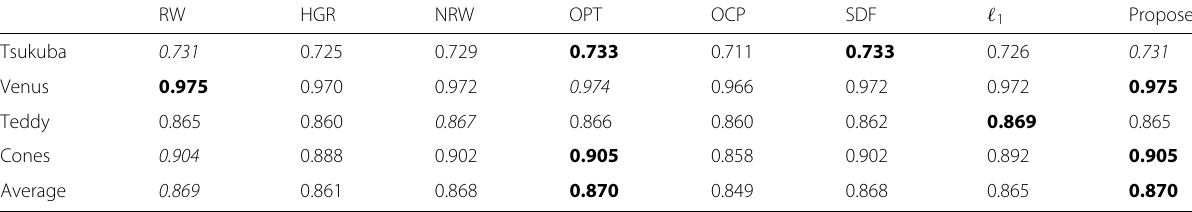
Table 4 SSIM of estimated depth on Middlebury datasets when cross-boundary scribbles are absent RW HGR NRW OPT OCP SDF (cid:2) 1